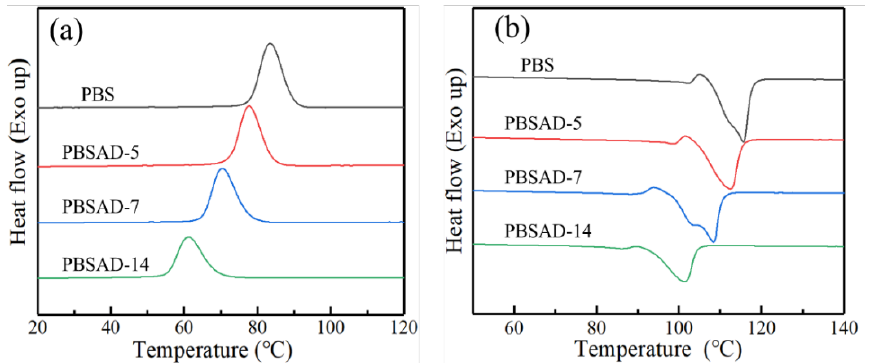
Figure 3. DSC thermograms of polyesters ( a ) being cooled from melt and ( b ) the subsequent heating process at a rate of 10 °C/min.